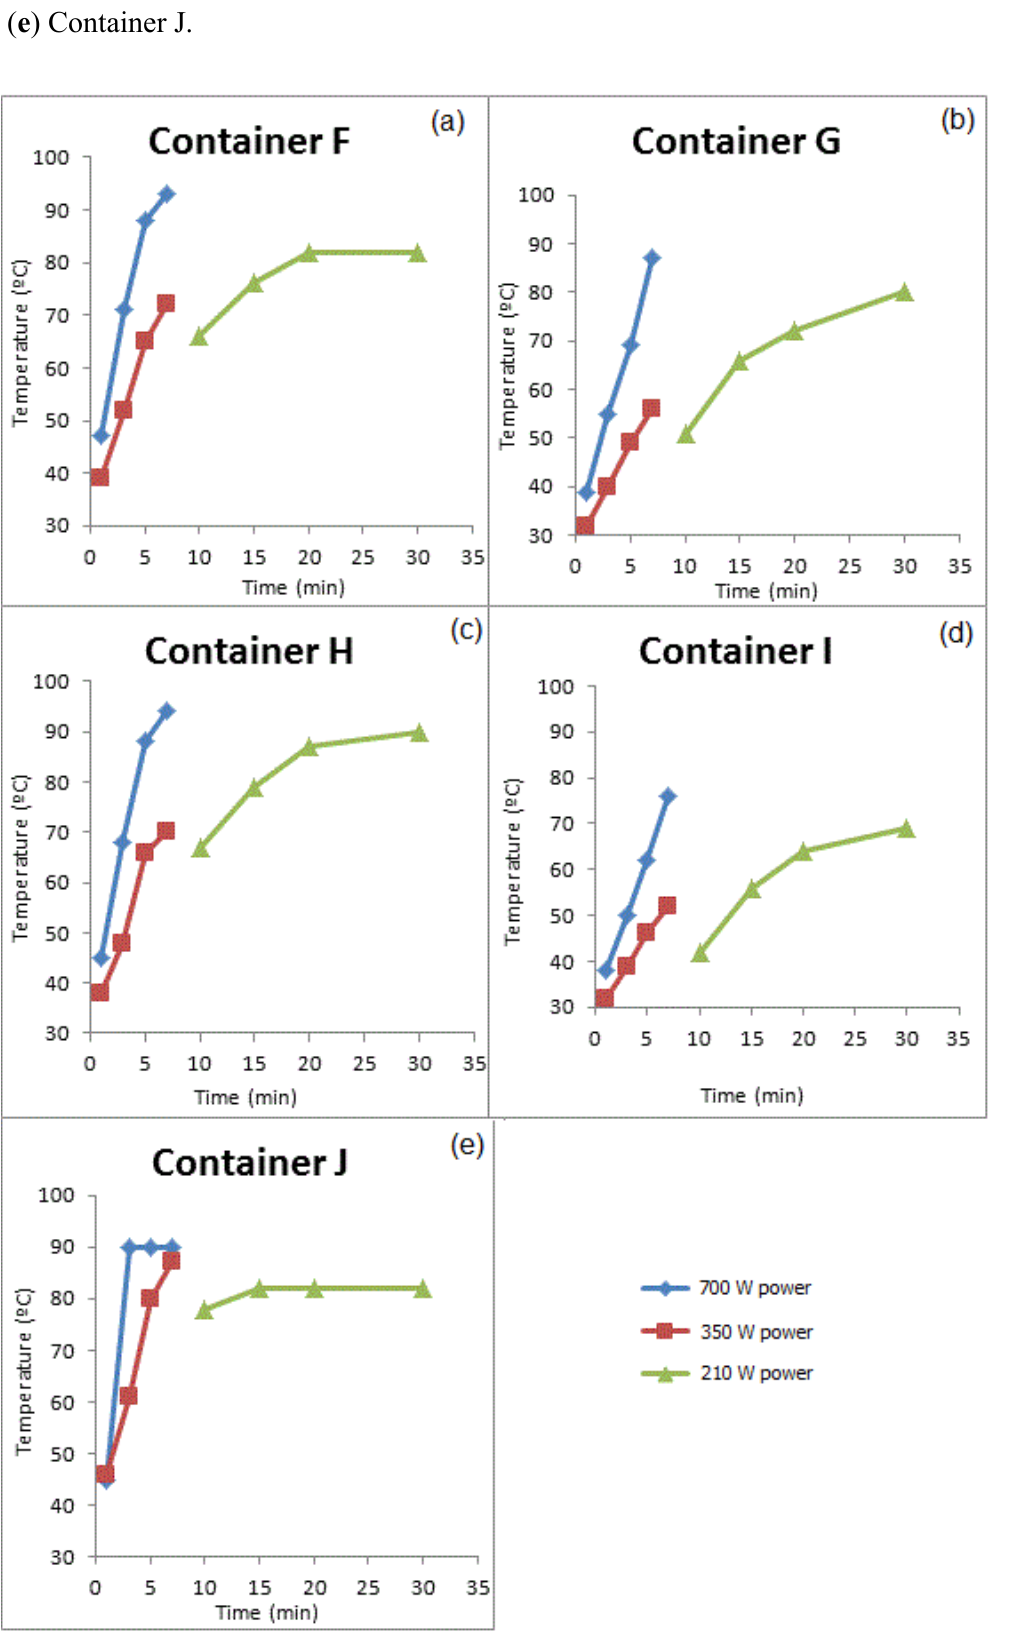
Figure 6. Temperatures of simulants measured for times and powers studied for Group II containers ( a ) container F, ( b ) Container G, ( c ) Container H, ( d ) Container I, and ( e ) Container